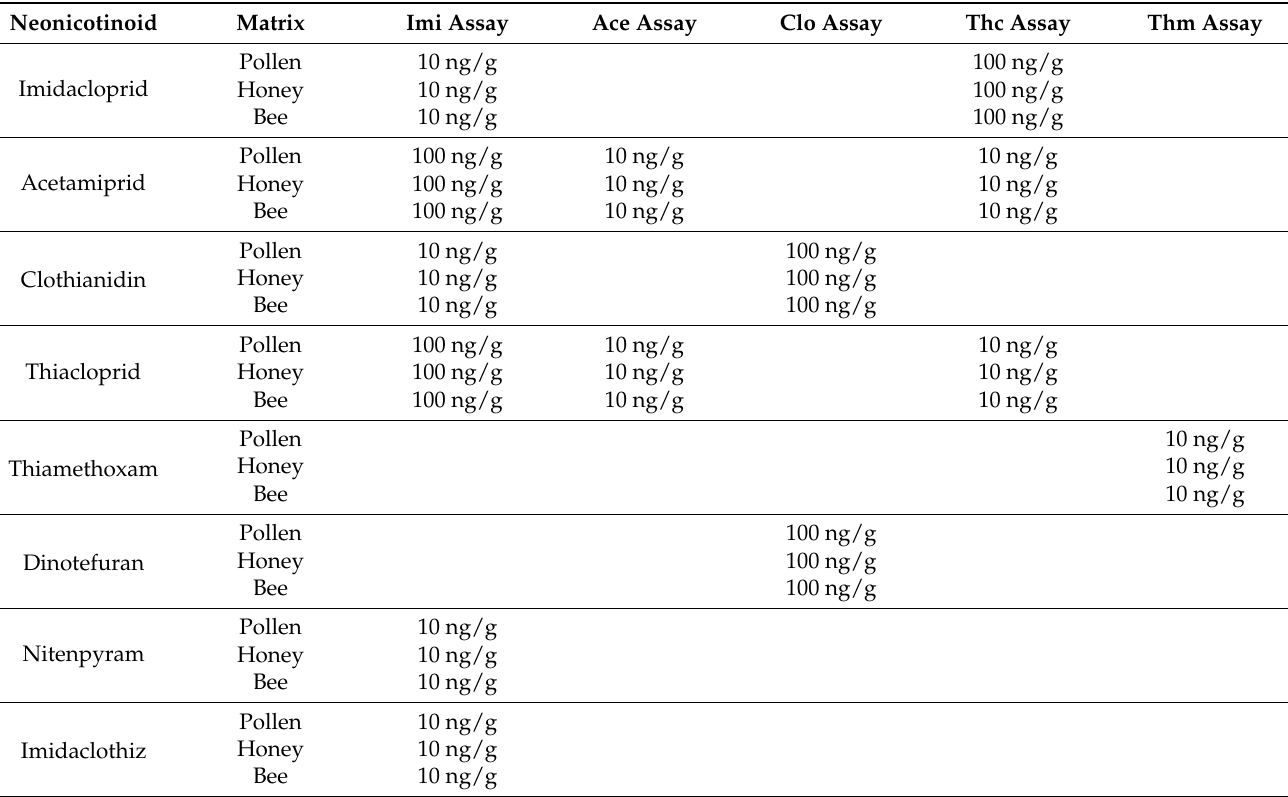
Table 4. Overview of neonicotinoid profiling capabilities in pollen, honey and honeybees by the five nMIAs that were tested at 10 ng/g and 100 ng/g